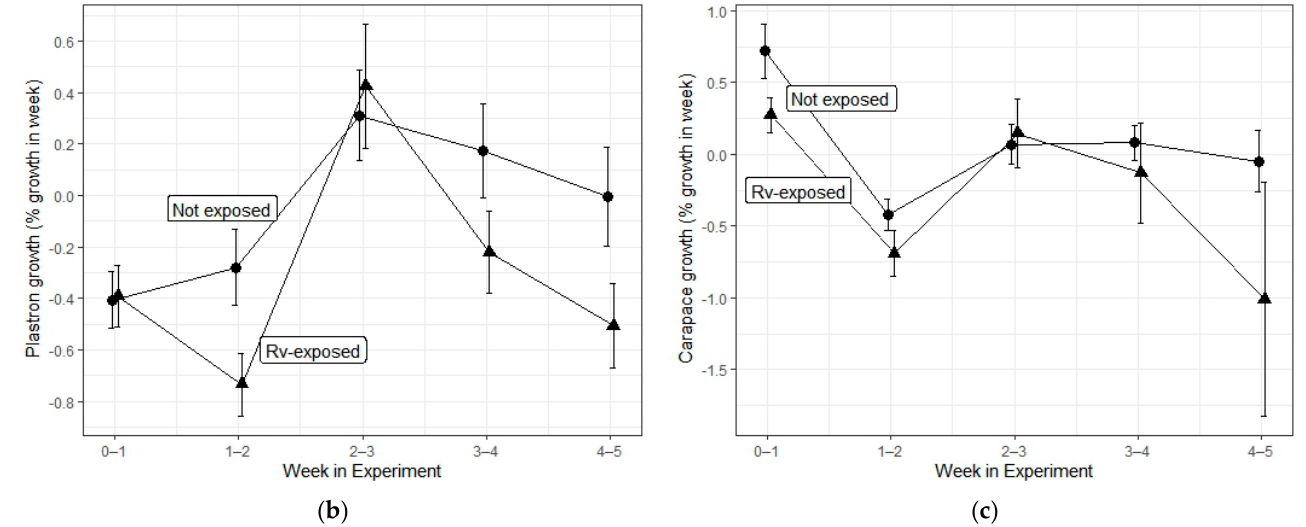
Figure 5. Response variables for hatchling turtles ( Trachemys scripta elegans ) in a 5-week experiment wherein they were exposed to ranavirus (Rv-exposed), or not, for controls. Rv-exposed turtles were injected with 100 uL of ranavirus-infected cell lysate (FV3; 6.3 × 10 4 TCID 50 ) into the pectoral muscles after 1 week of the experiment; controls were injected similarly with cell culture medium used for culturing the virus. Turtles were exposed to herbicides via water bath during the first 3 weeks of the experiment; all groups are combined here because these treatments had no impact on the response variables shown here on the y -axes: change in mass ( a ), plastron ( b ), and carapace ( c ). Points represent the mean (±1 SE) for Rv-exposed and control hatchlings for each week of experiment.